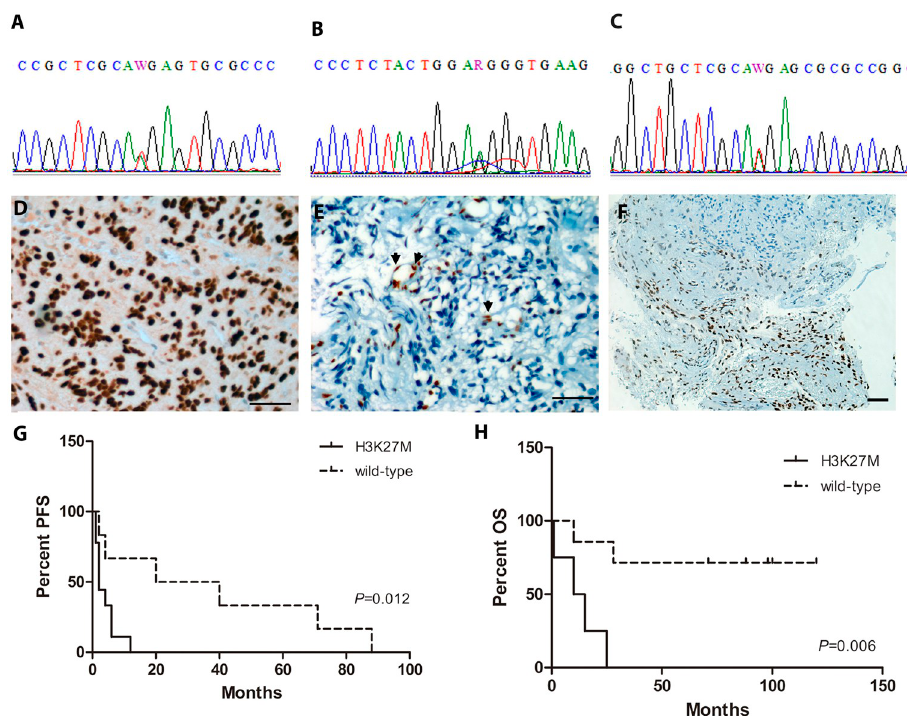
Fig 3. Histone 3 mutation analysis. A) Representative Sanger sequencing chromatogram showing double peaks in c.83A > T (p.K27M), indicating a H3K27M heterozygous mutation in isoform H3.3. B) Representative Sanger sequencing chromatogram showing double peaks in c.103A > G (p.G34R), indicating a H3G34R heterozygous mutation in isoform H3.3. C) Representative Sanger sequencing chromatogram showing double peaks in A > T (p. K27M), indicating a H3K27M heterozygous mutation in isoform H3.1. D) Representative immunohistochemistry for positive midline diffuse glioma H3K27M mutant case. Scale bar represents 50 μ m at 400x magnification. E) Representative immunohistochemistry for H3K27me3 in the H3.3 mutant isoform depicts a complete loss-of-staining in tumor cells, while endothelial cells retain a positive staining status (arrows). Scale bar represents 50 μ m at 400x magnification. F) Immunohistochemistry for H3K27me3 in the H3.1 mutant isoform case depicts a heterogeneous mosaic loss-of-staining. Scale bar represents 50 μ m at 200x magnification. G) Kaplan-Meyer progression free survival analysis in HGG. H) Kaplan-Meyer overall survival analysis in